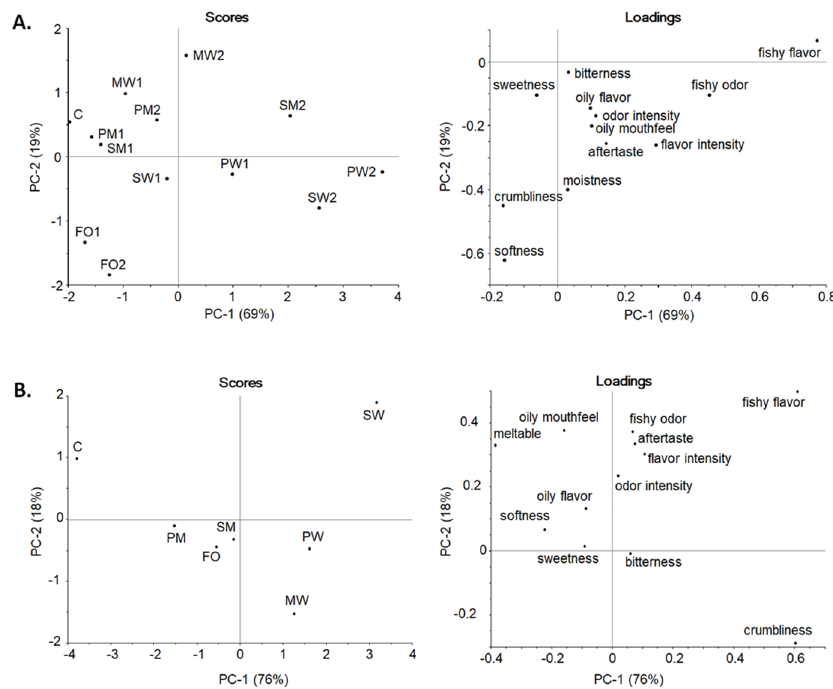
Figure 2. Consensus PCA scores and loadings plots of the descriptive sensory profile of ( A ). short- bread cookies and ( B ). chocolate. In scores plot: C = control, FO = fortified with non-encapsulated fish oil, M = maltodextrin, W = WPC = whey protein concentrate, S = soy protein, or P = pea protein as wall material, 1 = 1.5% oil, and 2 = 3.0% oil.